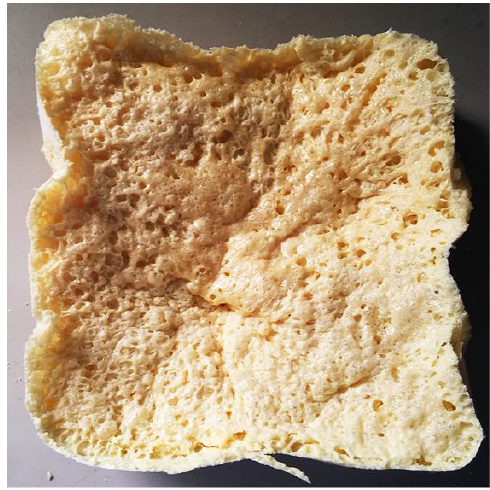
Figure 5. Appearance of Foam 700-30% after its collapse.